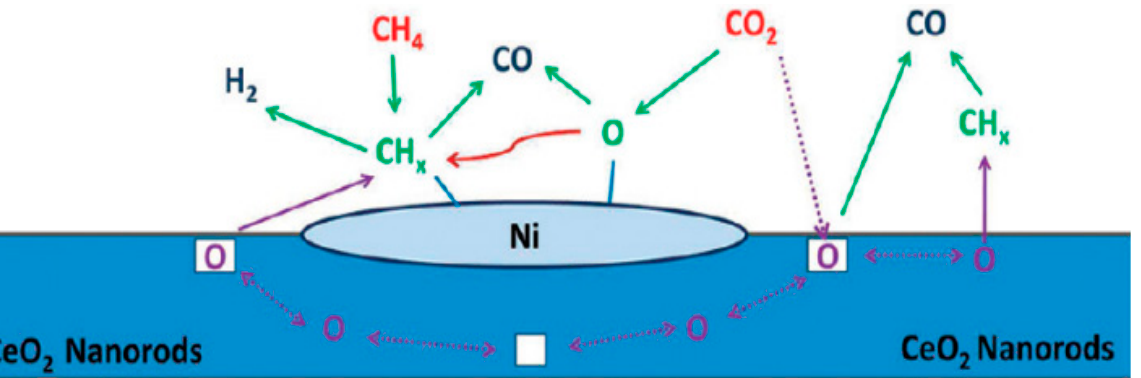
Figure 2. Catalytic mechanism diagram for DRM over Ni-supported ceria nanorods. Reprinted with permission from [75], copyright ACS, 2012.